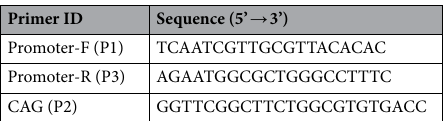
Table 3. List of oligonucleotides used in conventional RT-PCR